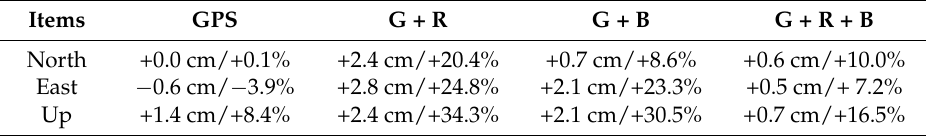
Figure 10. RMS of velocity offsets from PPP mode ( top ), the PPP/INS tightly coupled integration mode without ( middle ) and with the HVCE adaptive scheme ( bottom ) using GPS, G + R, G + B, and G + R + B GNSS data.